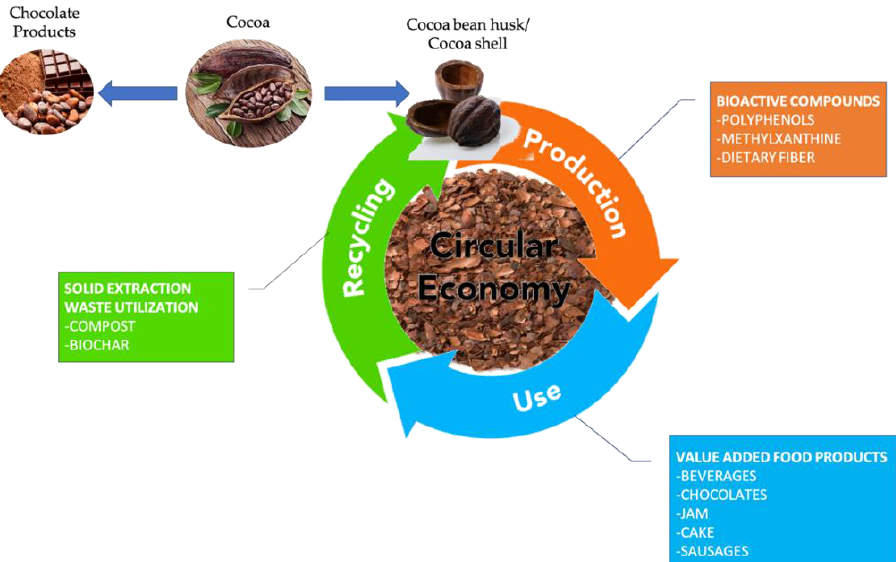
Figure 3. Circular economy concept for cocoa bean husk products. For the circular economy, the cocoa shell husk processed waste products (e.g., residue left after extraction of compounds) could be recycled/reused (e.g., biochar, compost) to provide a complete waste valorization solution with potential sustainable benefits.